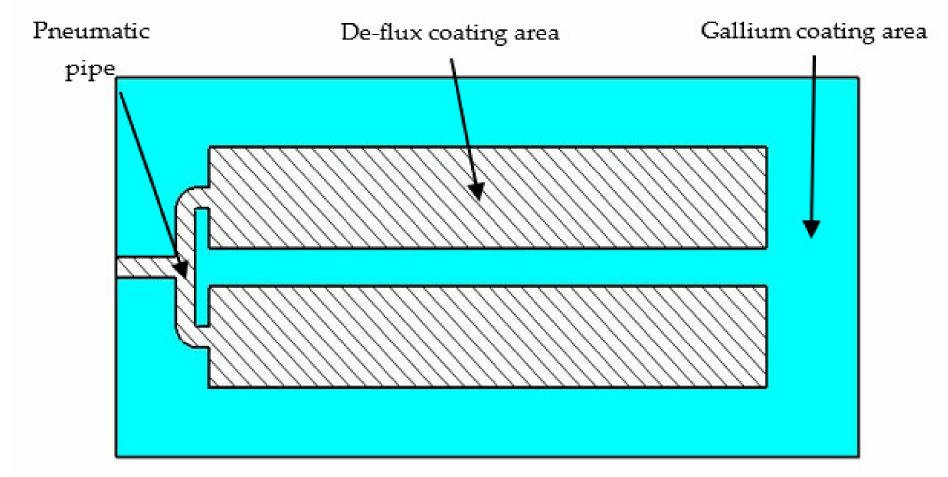
Figure 4. Area of Ga coating and de-flux coating on the sample surface.